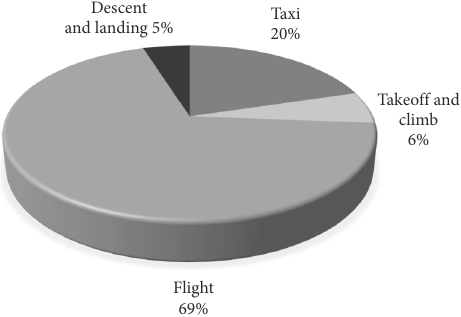
Figure 7. Mean time share of the given stages within the entire missions for flights 1, 2, 3